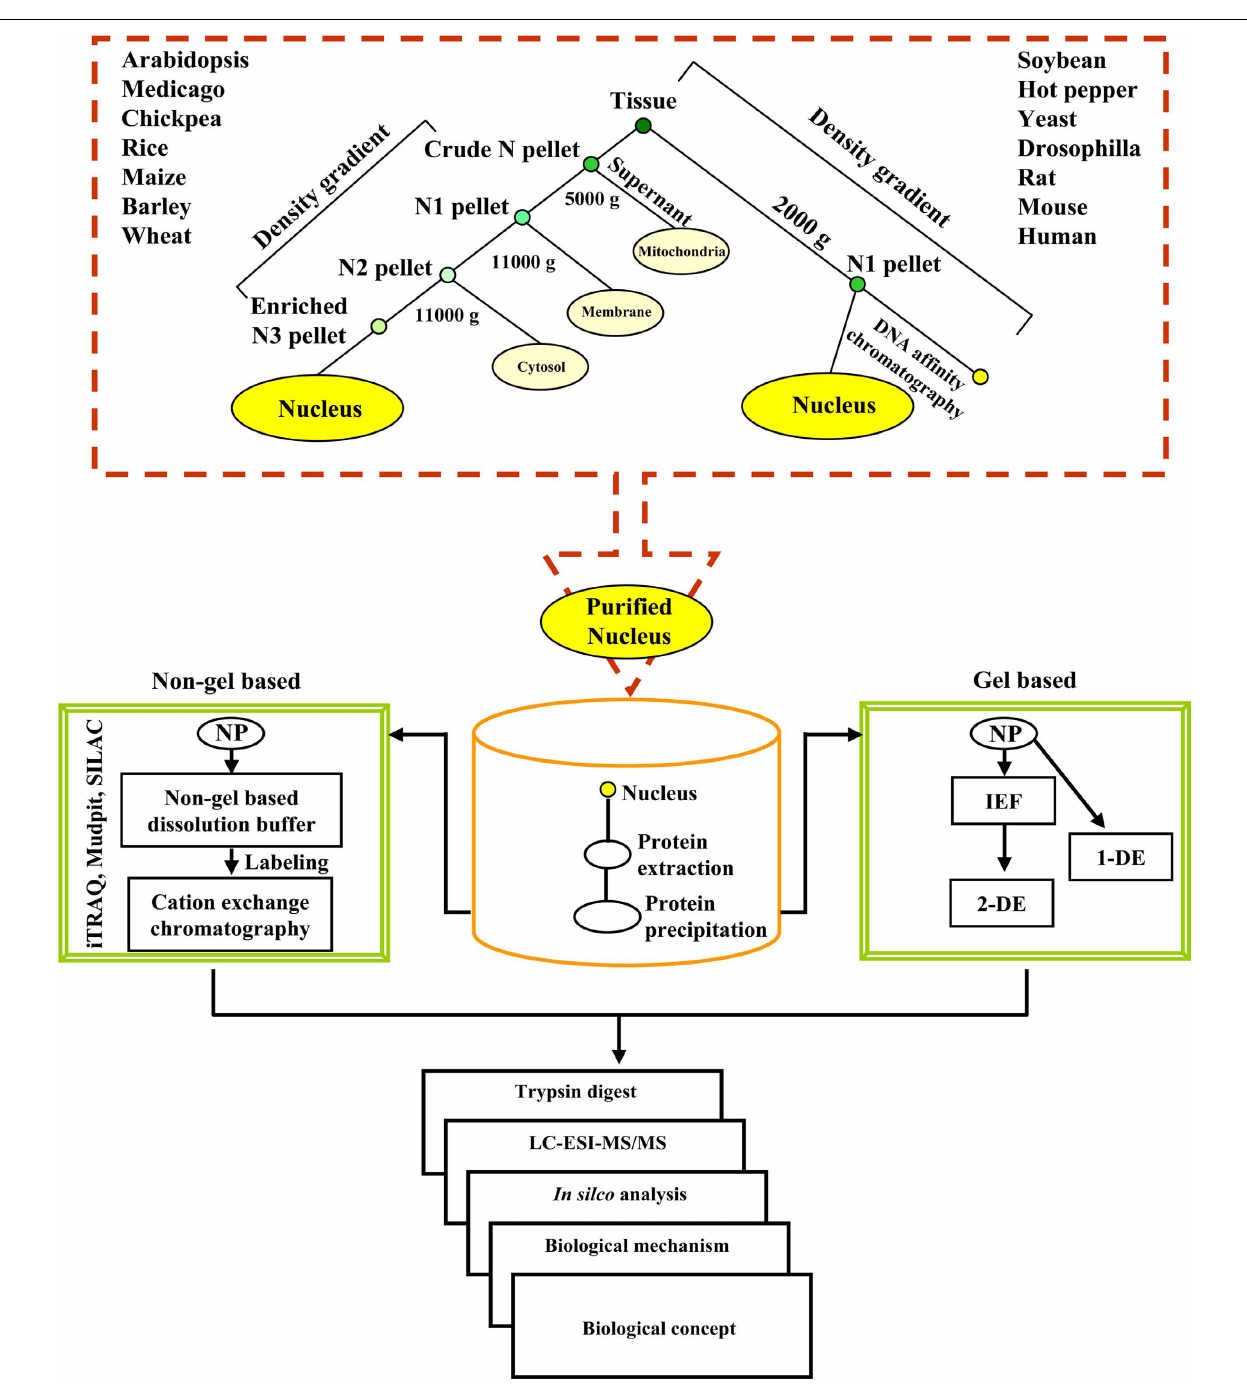
FIGURE 1 |A flowchart illustrating the overall experimental strategy for the analysis of the nuclear proteome. NP denotes nuclear protein.